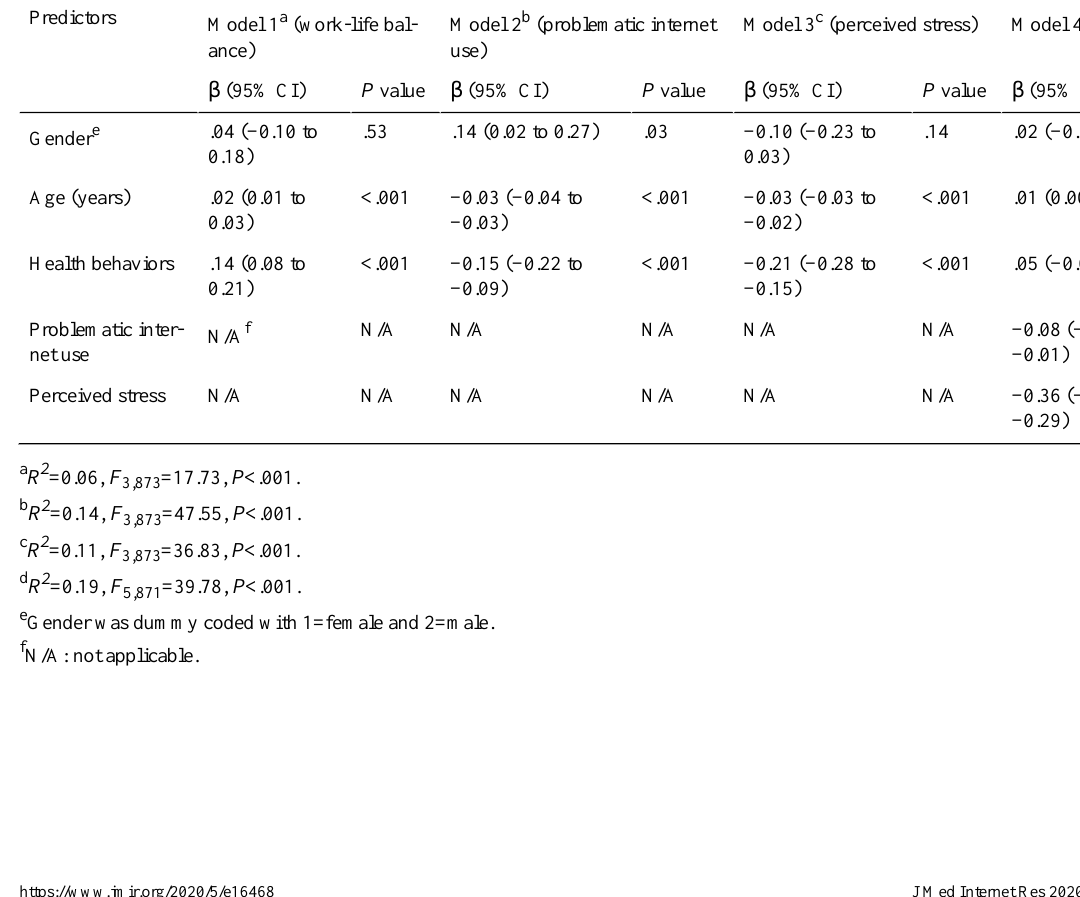
Table 3. Mediation effects of health behaviors on work-life